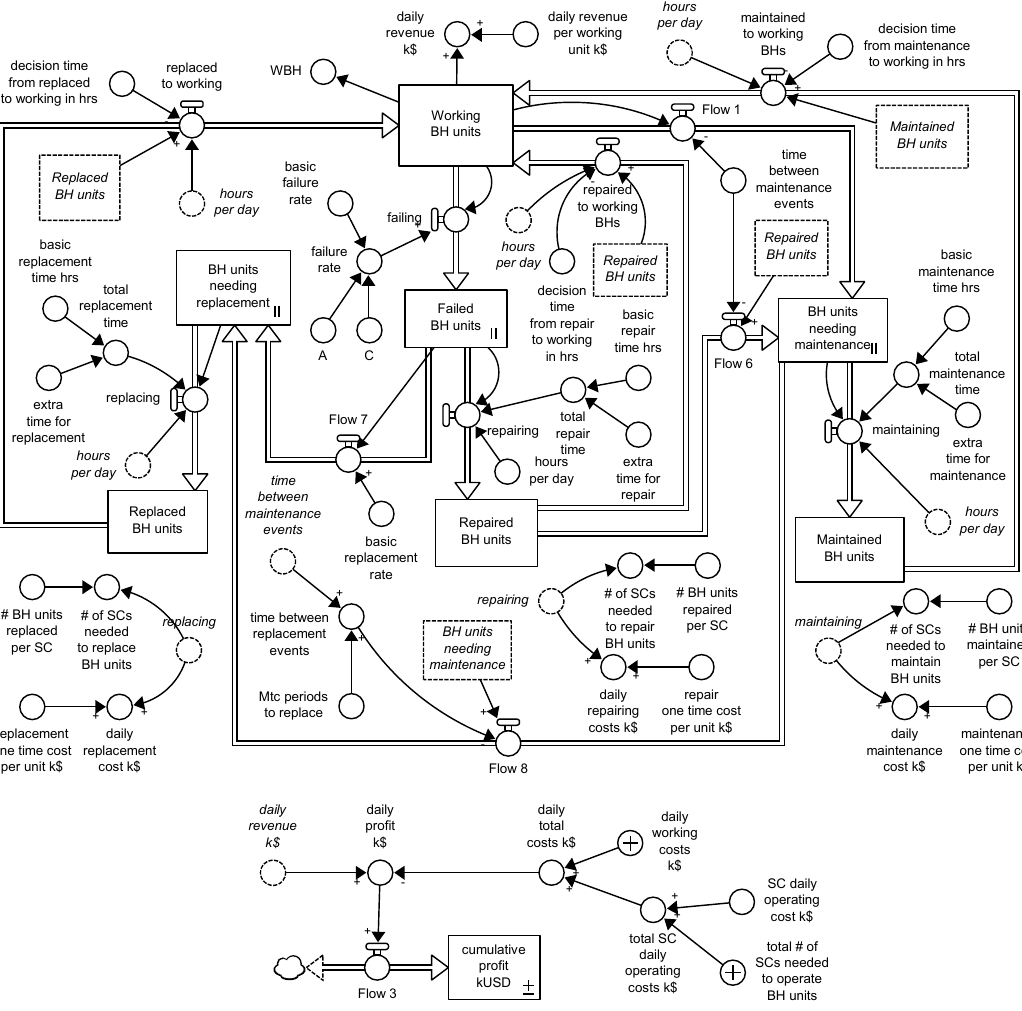
Figure 8. Stock-and-flow system dynamics (SD) model showing the dynamic between the different borehole equipment states.